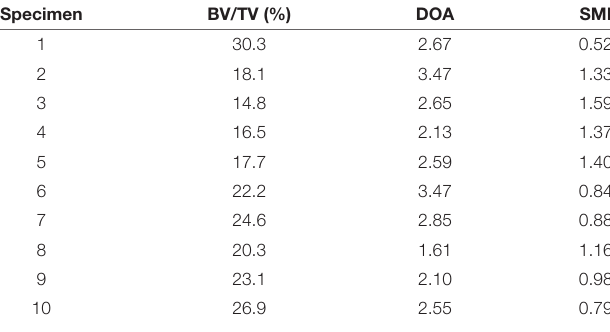
TABLE 2 | Morphological indices of the 10 used